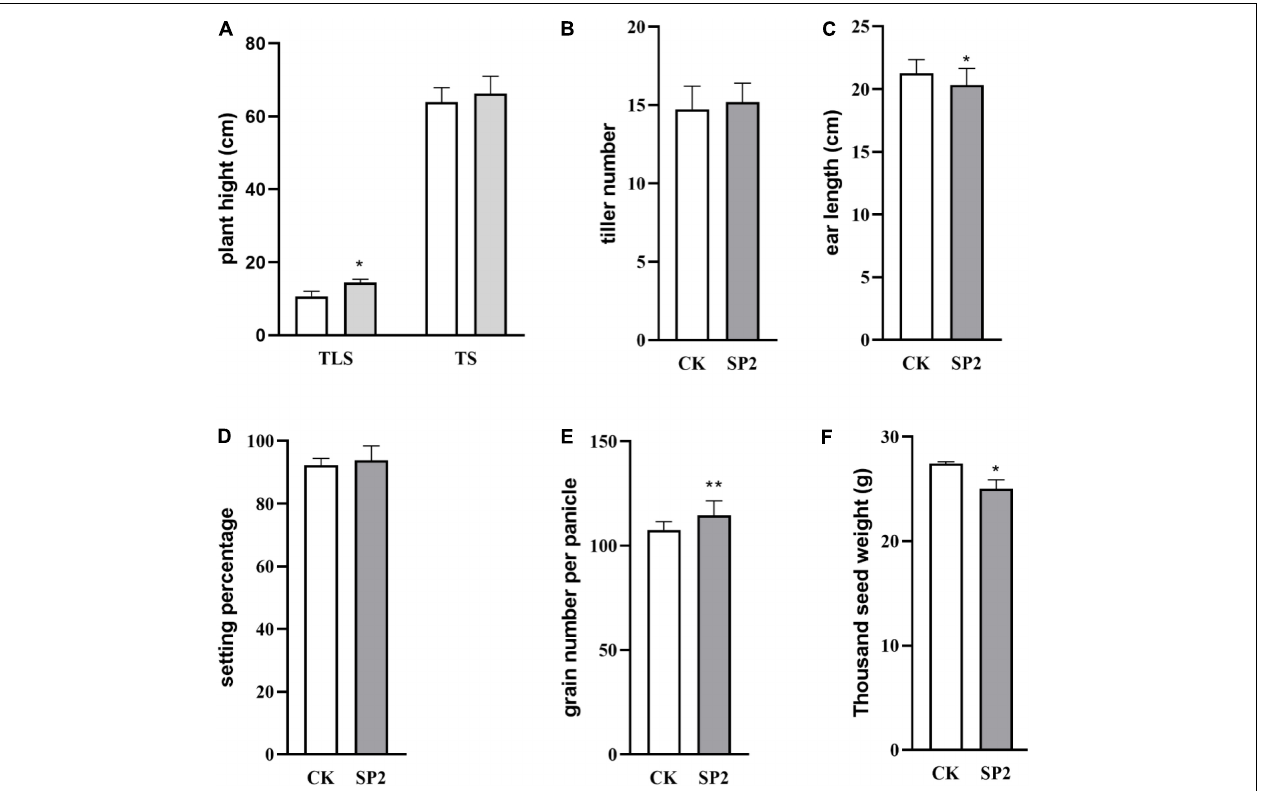
FIGURE 1 | Change of plant height (A) , tiller number (B) , ear length (C) , setting percentage (D) , grain number per panicle (E) , thousand seed weight (F) in rice different stages of growth and development. (TLS, three-leaf stage; TS, tillering stage; White column represents the control group; Gray column represents treatment group). Data are mean ± SD, n = 30, * and ** indicate significant difference at p < 0.05 and p < 0.01 by student t -test,